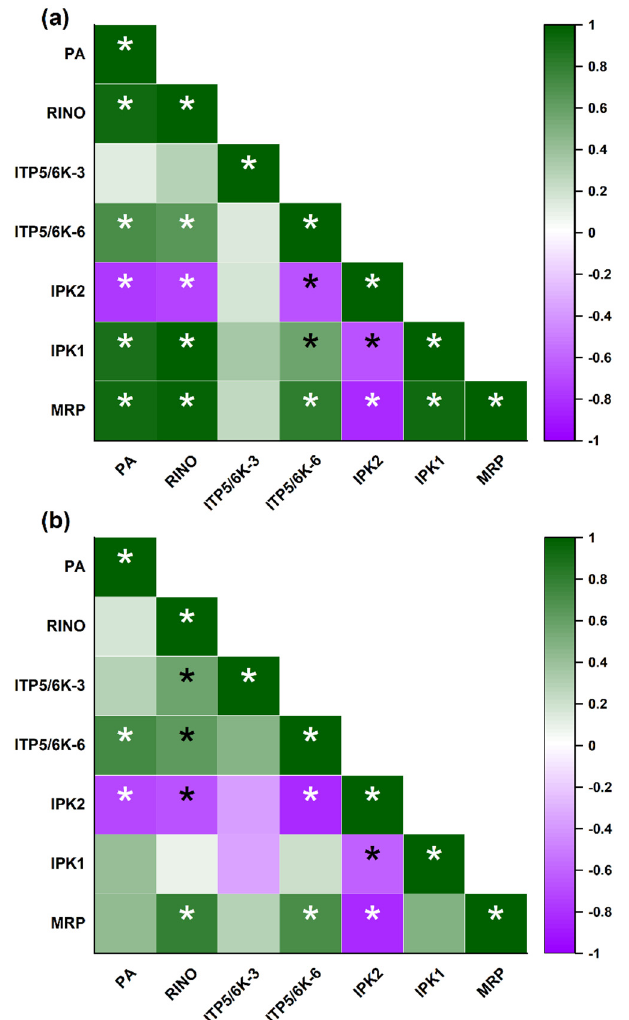
Figure 6. Pearson correlation between PA-related genes expressions (( a ) for 5 days after culture, ( b ) for 10 days after culture) and grain phytic acid (PA) concentrations. (XS110 for detached panicle culture). The symbol * represents significance at the level of p < 0.05.